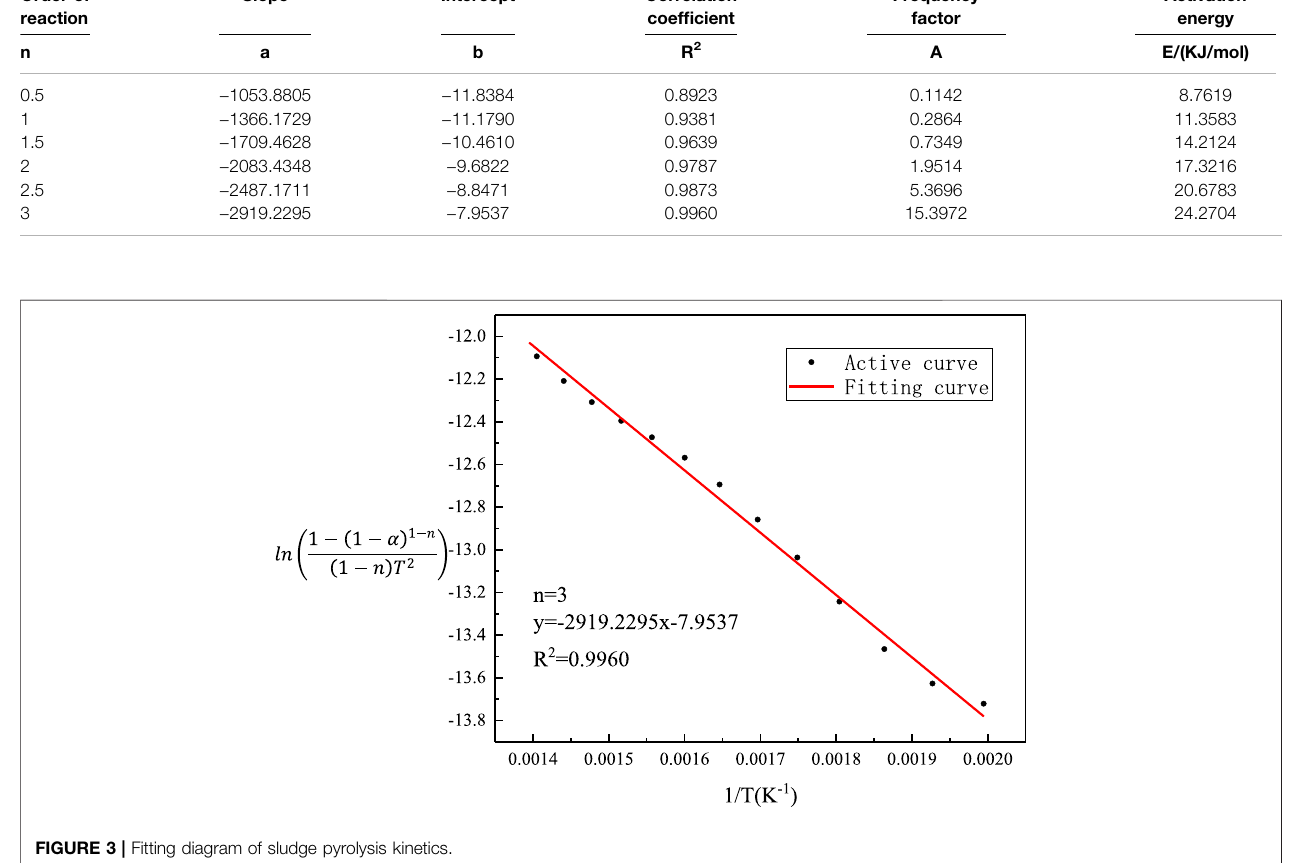
FIGURE 3 | Fitting diagram of sludge pyrolysis kinetics.